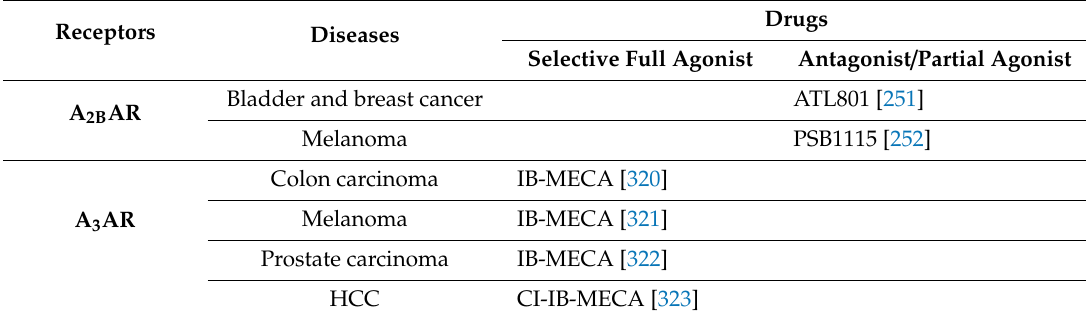
Table 4. Adenosine receptor drugs in